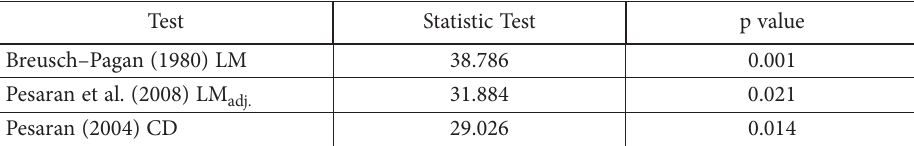
Table 3. Cross-sectional dependence tests (H 0 : There is cross-sectional independence) Test